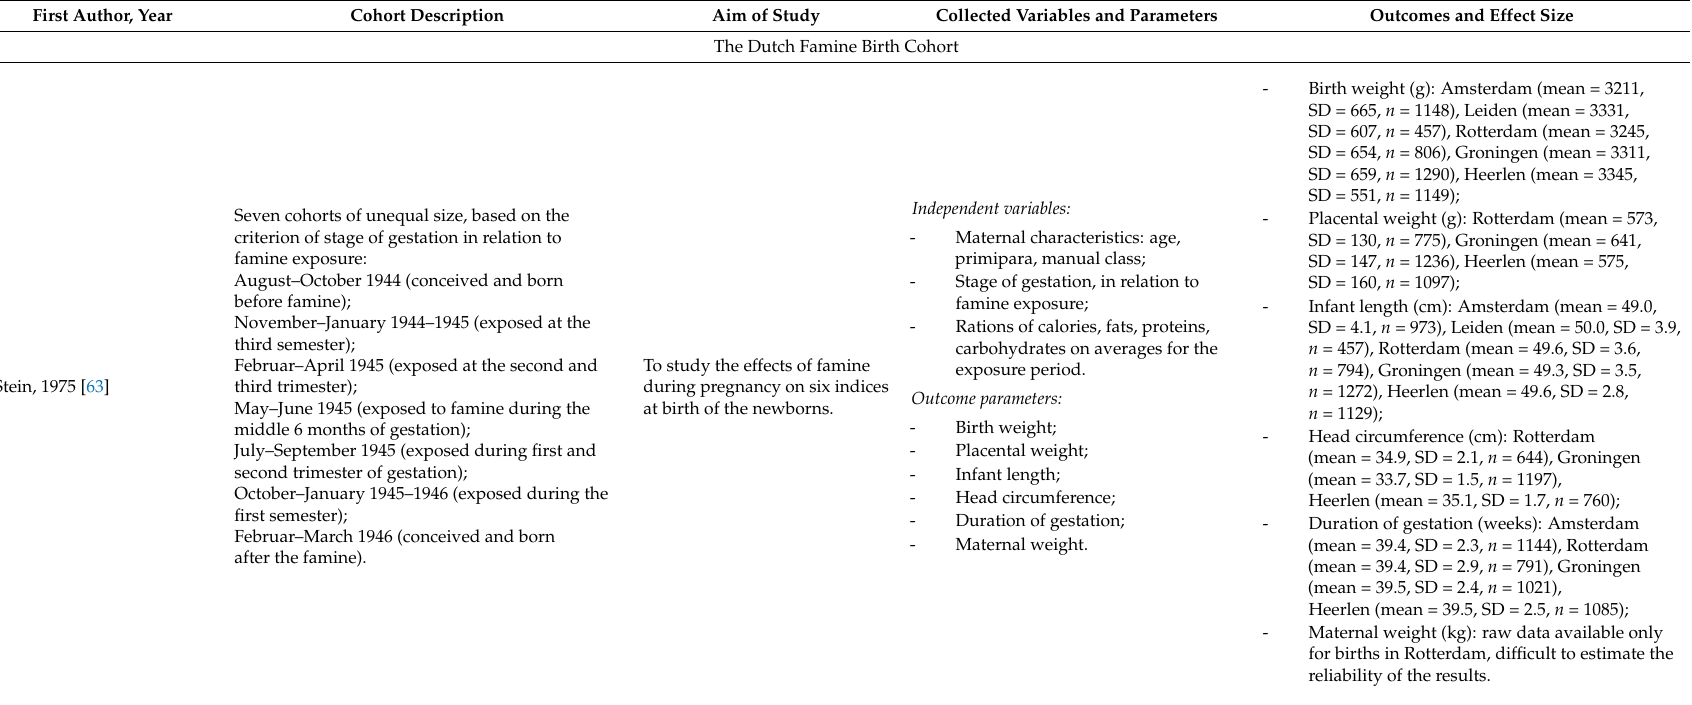
Table A1. Description of the included studies, the variables and parameters collected and the main findings ( p -value = probability value, SD = standard deviation, CI = confidence interval, n = number of